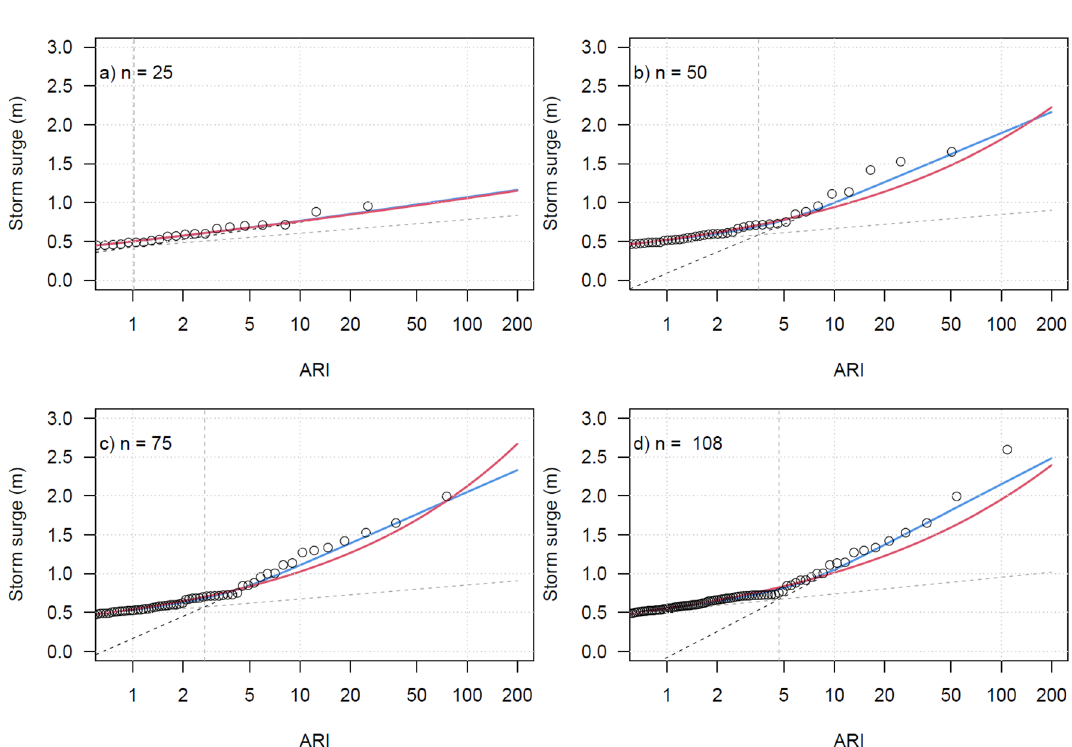
Figure 3. Galveston tide gauge storm surge (tide removed) EVD sensitivity to record length ( n ). Empirically ranked annual maximum storm tide (black circles) with fitted MC Gumbel (grey and black dashed lines), continuous MC (blue line) and GEV (red line) EVDs using the first n years of annual maxima, a) n = 25, b) n = 50, c) n = 75 and d) n = 108. Vertical thick grey dashed line indicates the intersection of the two MC Gumbel